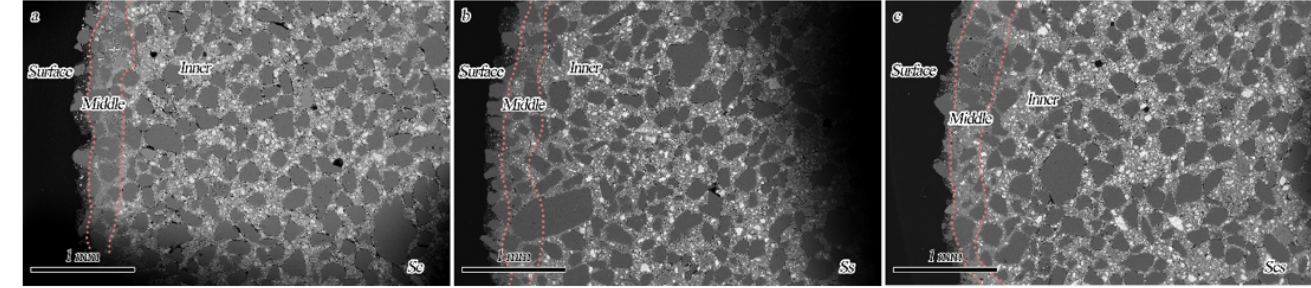
Figure 9. Microscopic BSE images of specimens after drying–immersion cycles in the three erosive salt environments: ( a ) Sc; ( b ) Ss; ( c ) Scs.